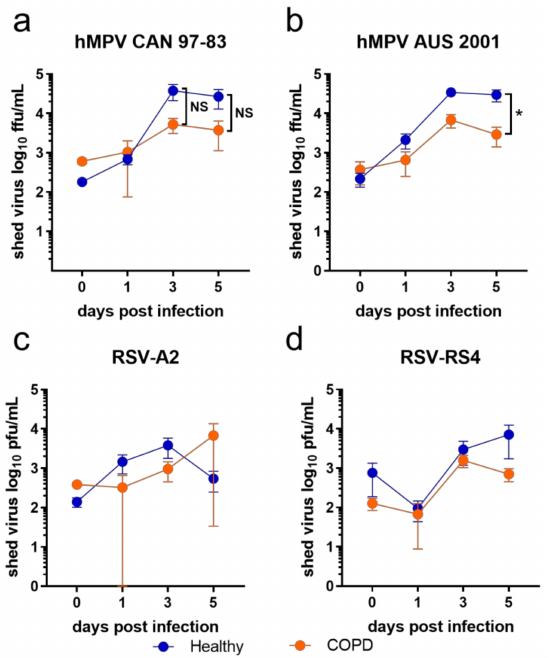
Figure 1. Viral shedding from submerged monolayers of BECs infected with ( a ) CAN 97-83 ( b ) AUS- 001 ( c ) A2 or ( d ) RS4, MOI 0.1. Shed virus was quantified by focus/plaque assay at day 0, 1, 3, and 5 post-infection. The symbols represent the mean ± SEM. n = 5 for both COPD and healthy groups. Unpaired t -tests show statistical significance, * denotes p < 0.05 for COPD group compared to the healthy group.